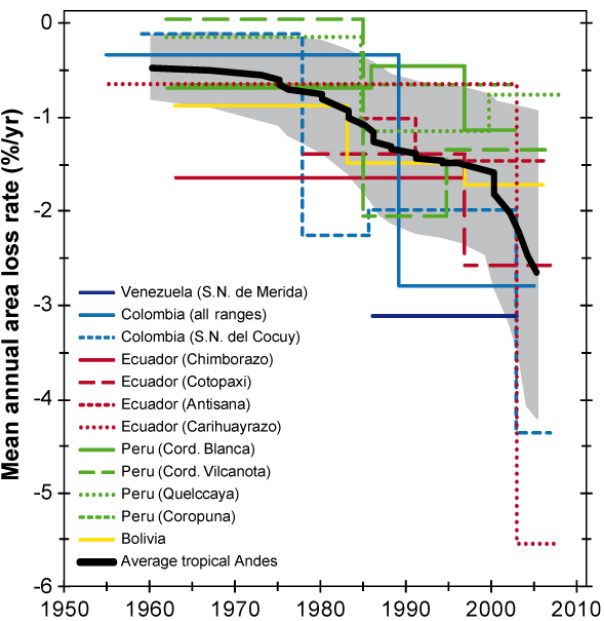
Fig. 4. Compilation of mean annual area loss rates for different time periods for glaciated areas between Venezuela and Bolivia. Surface areas have been computed from maps, aerial photographs, satellite images and direct topographical measurements. Sources are given in the text. Note that the average (smoothed using a 5-yr running mean) is computed from a varying number of values depending on the period concerned because fewer data were available for the first decades of the study period. The grey box around the average rep- resents the uncertainty corresponding to ± 1standard deviation.